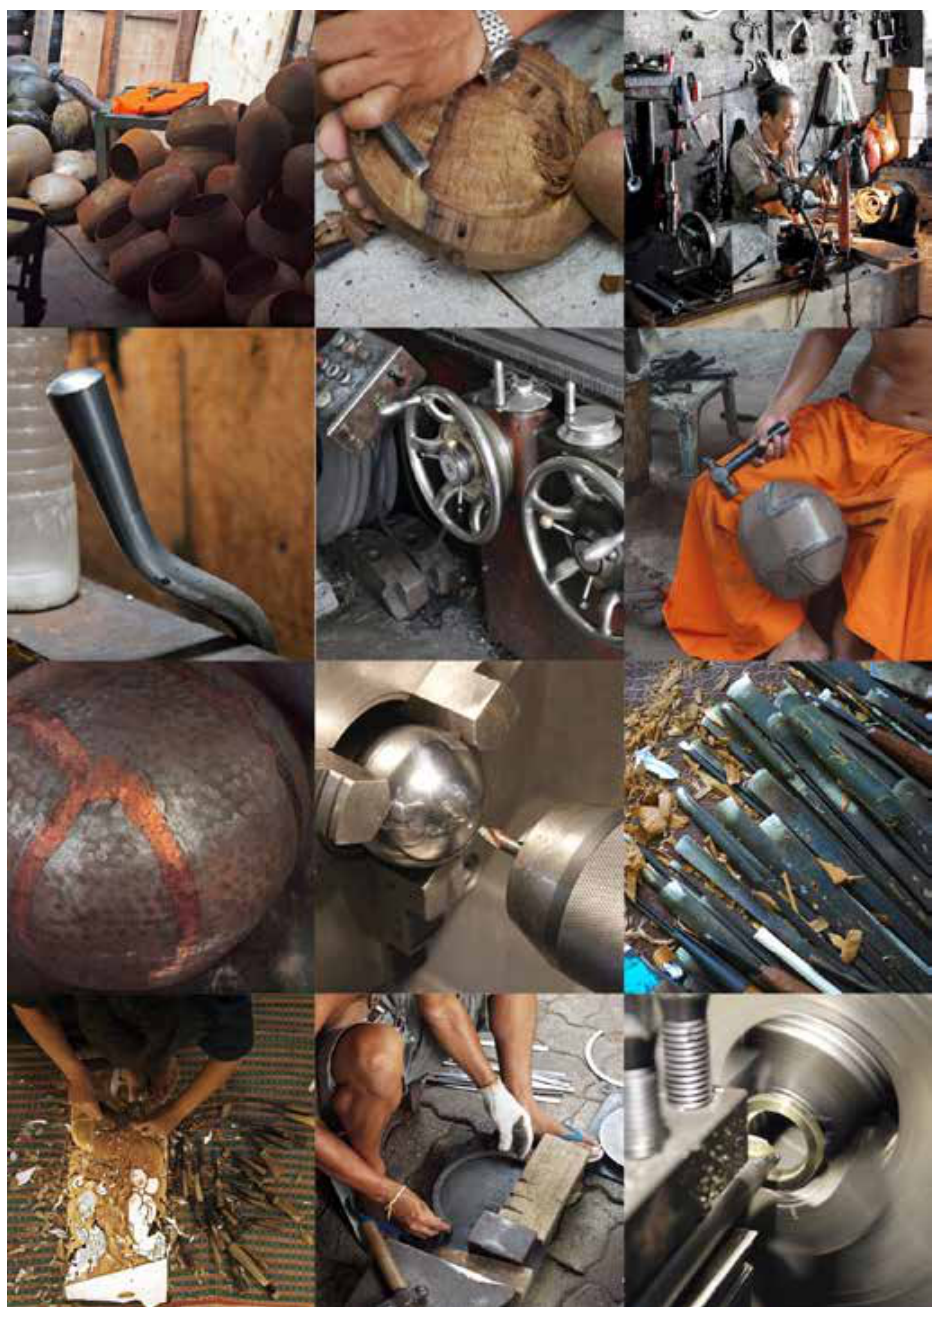
Figure 4: Observing craftsmanship. Workshops and craftsmen help launch our design explorations and material understanding. Our relationship with the makers is as important and complex as our relationship with the materials and techniques. Source: